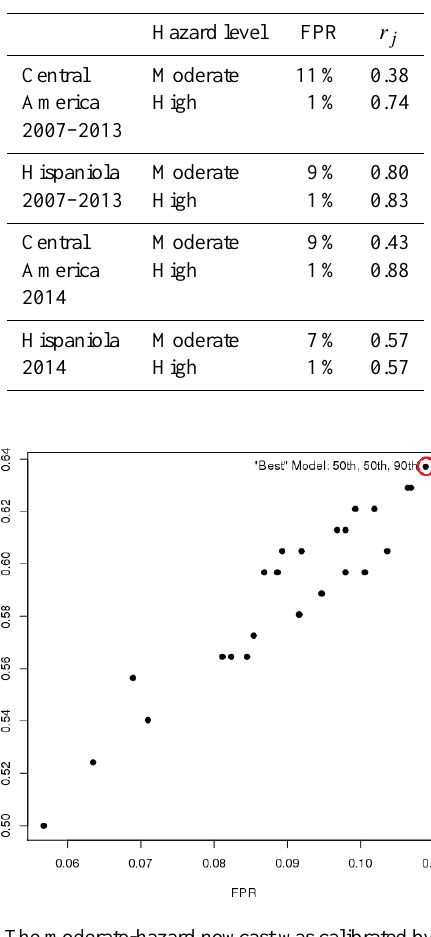
Figure 8. The moderate-hazard nowcast was calibrated by calculat- ing r j , the distance to perfect classification, for a variety of rain- fall and ARI thresholds that ranged from the 50th to the 95th per- centile values. The lowest (best) r j value was observed for the 50th percentile ARI, 50th percentile rainfall over moist-condition ground and 90th percentile rainfall over dry-condition ground. These thresholds are represented by the second dot from the right in the red circle. Ideally, the choice of the “best” rainfall thresh- olds depends upon the intended use of the model and the economic costs of different errors. Since these details are not yet available, r j was selected to provide a balanced and easily interpreted measure of model